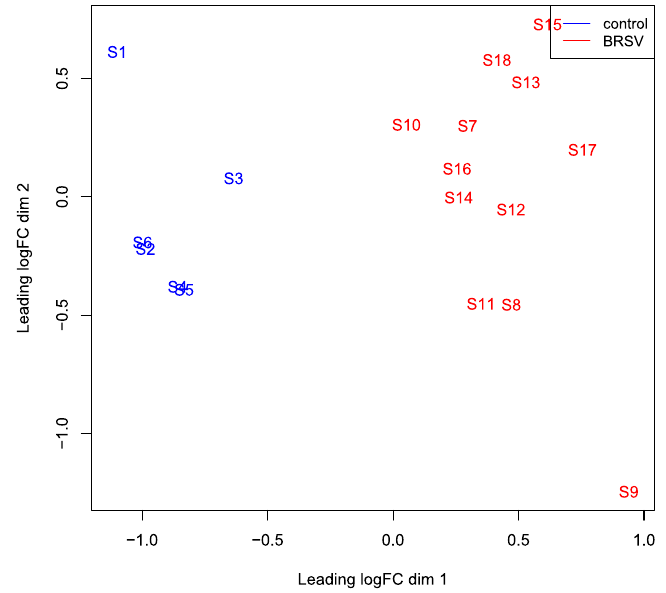
Figure 1. An MDS plot generated in EdgeR 12,13 illustrating the similarity of the samples based on the first two principal components of gene expression covariance matrix among individuals. Samples from BRSV challenged calves are coloured in red and samples from control calves are coloured in blue. The numbers (1–18) refer to the calf ID and the letter S in front of the numbers refers to the word